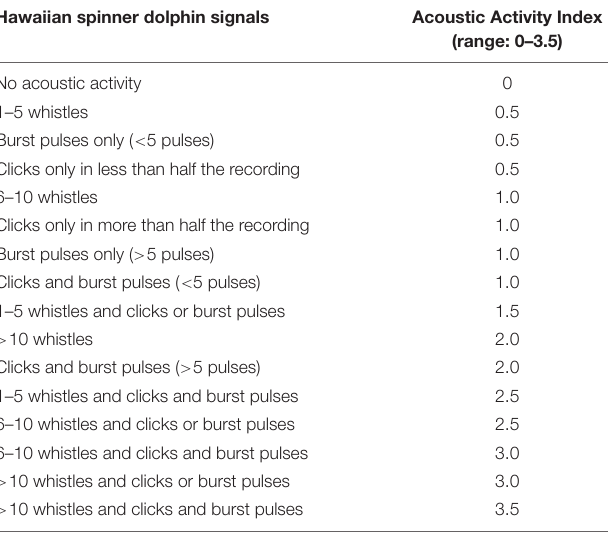
TABLE 2 | Acoustic Activity Index (AAI) based on the quantity and type of Hawaiian spinner dolphin signals within each 30-s